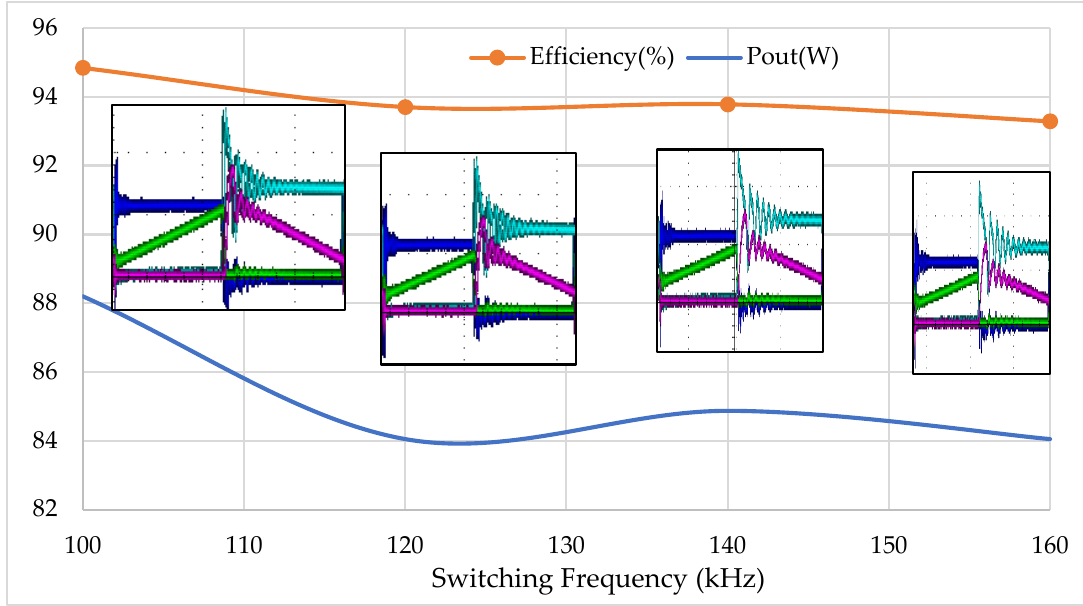
Figure 18. CCM for Vo = 20 V using Type 2A cascode.